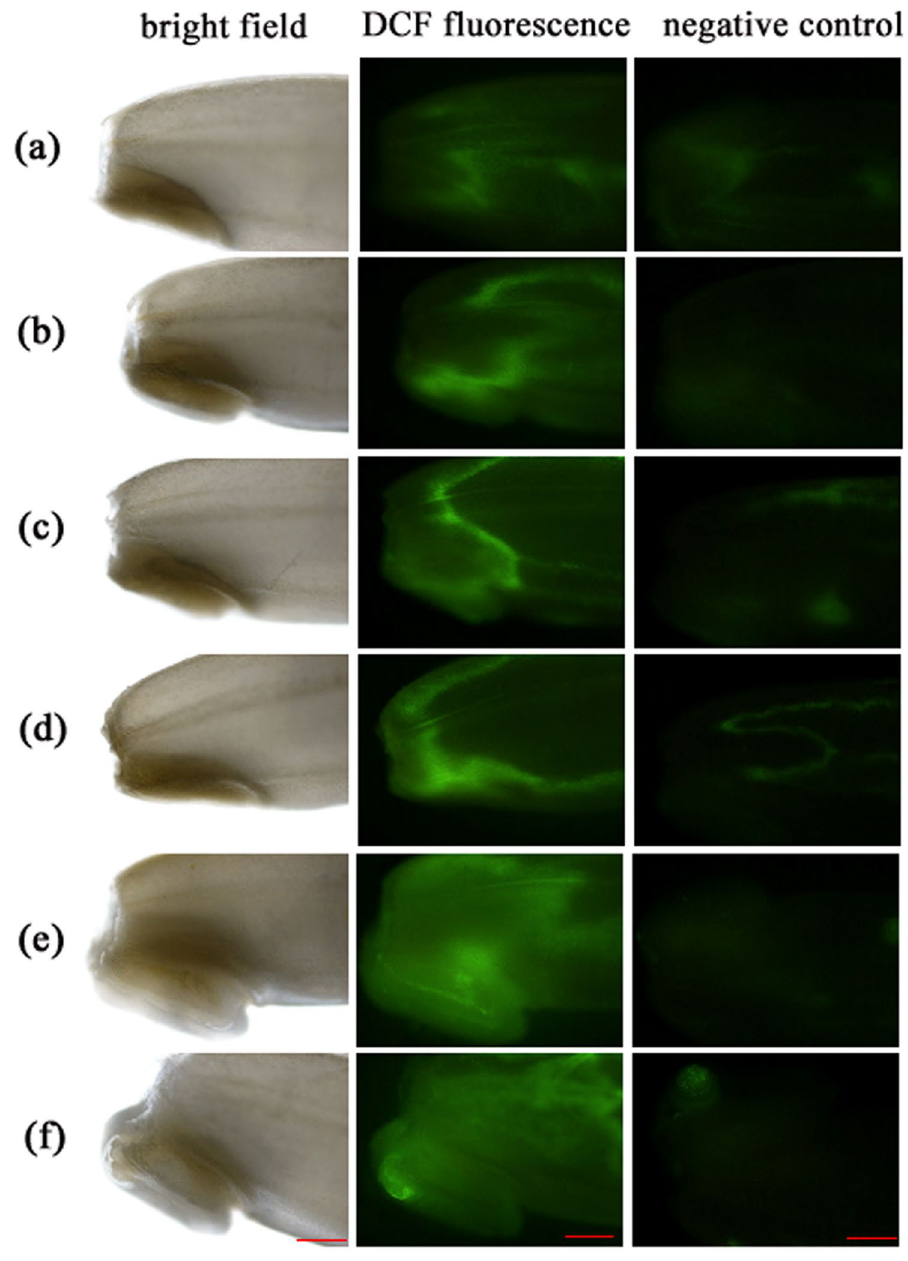
Figure 8. Localization of H 2 O 2 of rice seeds imbibed for 24 h using in vivo fluorescence imaging technique. Seeds imbibed at 24 h were loaded with DCF-DA fluorescence probe for 30 min and subjected to fluorescence microscopy, while seeds pre-incubated with ascorbate (peroxide scavenger) before loading with fluorescence probe were used as negative control. Bright filed images were also recorded. Representative images of imbibed seeds of ( a ) unprimed control, ( b ) hydropriming, ( c ) AgNO 3 10 priming, ( d ) AgNO 3 20 priming, ( e ) AgNPs10 priming, and ( f ) AgNPs20 priming treatments were presented. (Scale bar = 20 µ